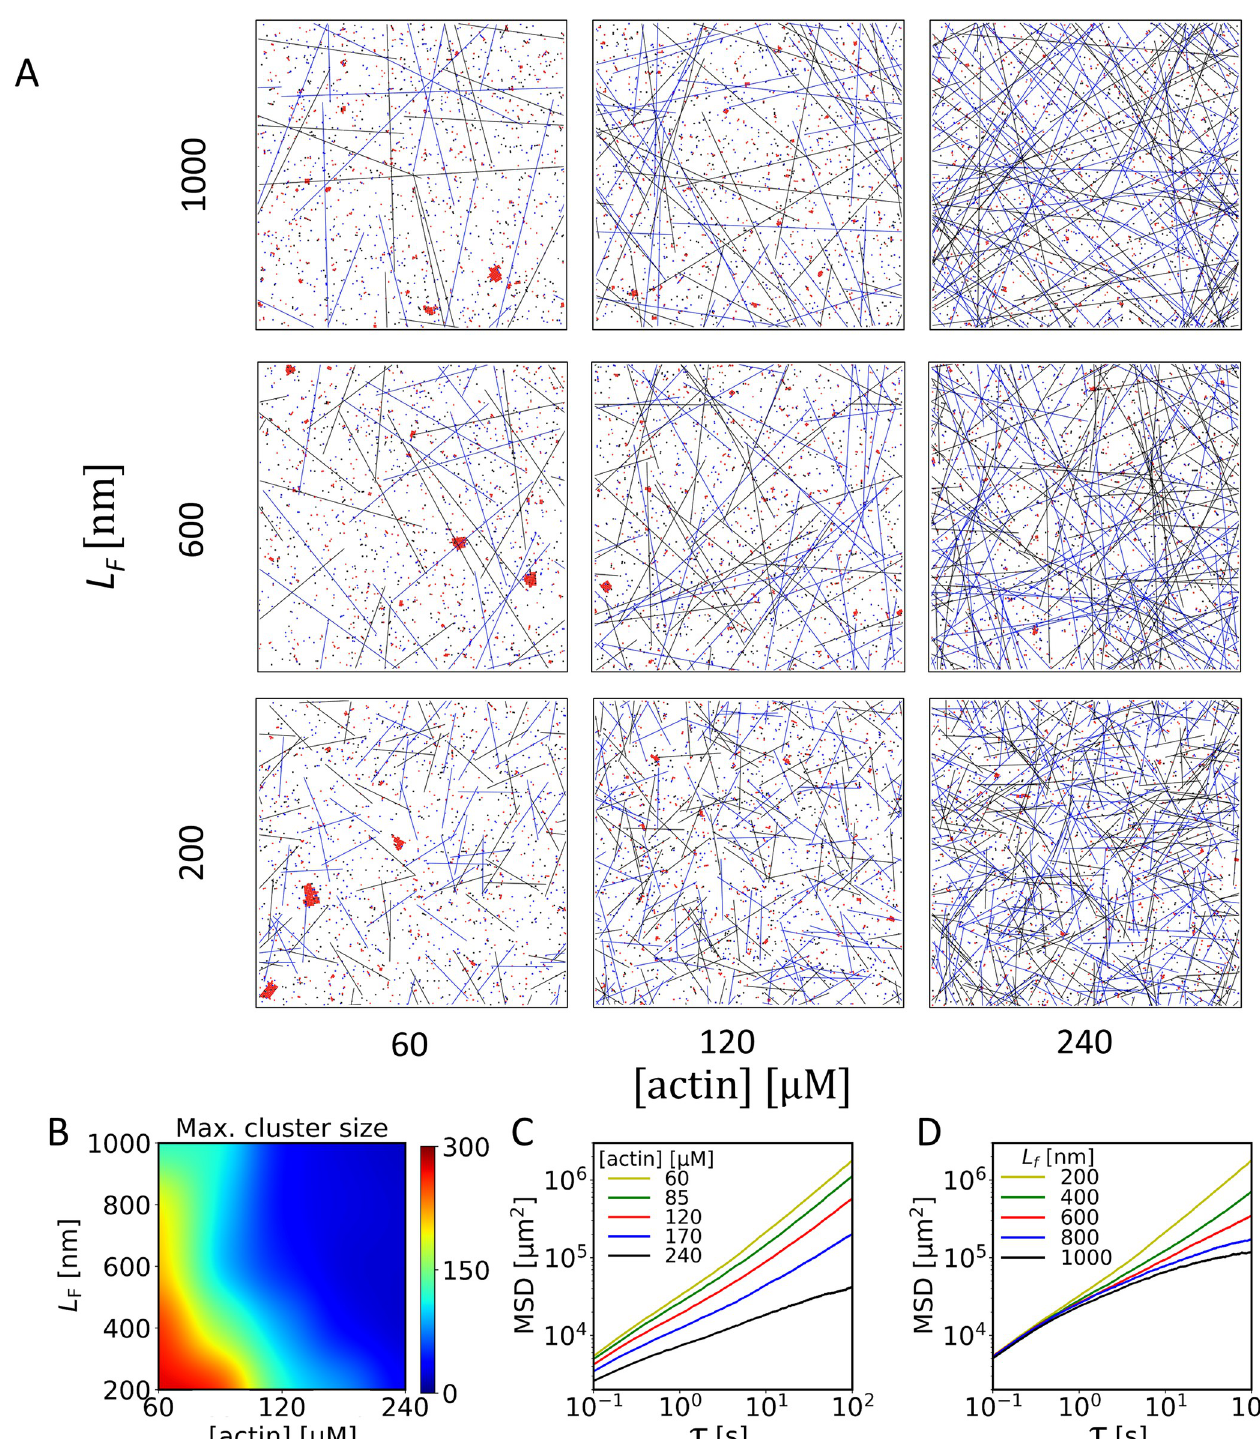
Fig 3. The presence of F-actin reduces the diffusivity of cadherins. (A) Snapshots of simulations at 100 s with a range of actin concentrations, [actin], and F- actin length, L F , with k cis ¼ 10 5 s (cid:0) 1 ; k cis ¼ 10 3 s (cid:0) 1 , [cad] = 1200 μ m -2 . (B) Maximum size of clusters as a function of actin concentration and F-actin length. ass dis Clusters tend to be smaller with higher actin concentration and F-actin length. (C) Mean squared displacement (MSD) of cadherin molecules with different actin concentrations and L F = 200 nm. As actin concentration increases, the magnitude and slope of MSD were reduced, which is attributed to smaller meshes formed by F-actins. The consistently lower slope with higher actin concentration indicates sub-diffusive motions. (D) MSD with different F-actin length and